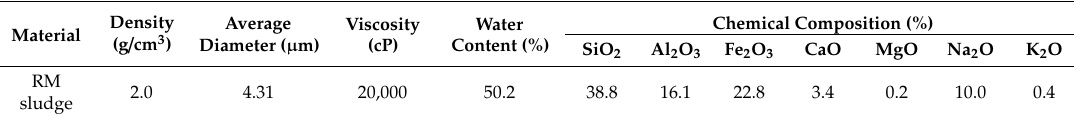
Table 2. Physical properties of thickener and antifoamer.